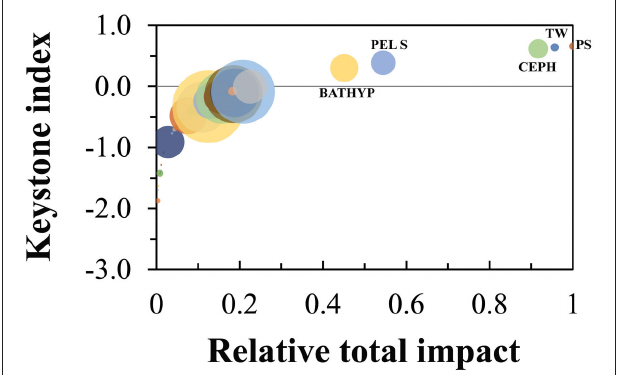
FIGURE 8 | Keystoneness analysis for each functional group, according to Libralato et al. (2006), of the Azores ecosystem model for the reference year 1997. The keystoneness index is shown on the vertical axis, the relative total impact on the horizontal axis. BATHYP is bathypelagic fish, PEL S is small pelagic fish, CEPH is cephalopods, TW is toothed whales, and PS is pelagic sharks.